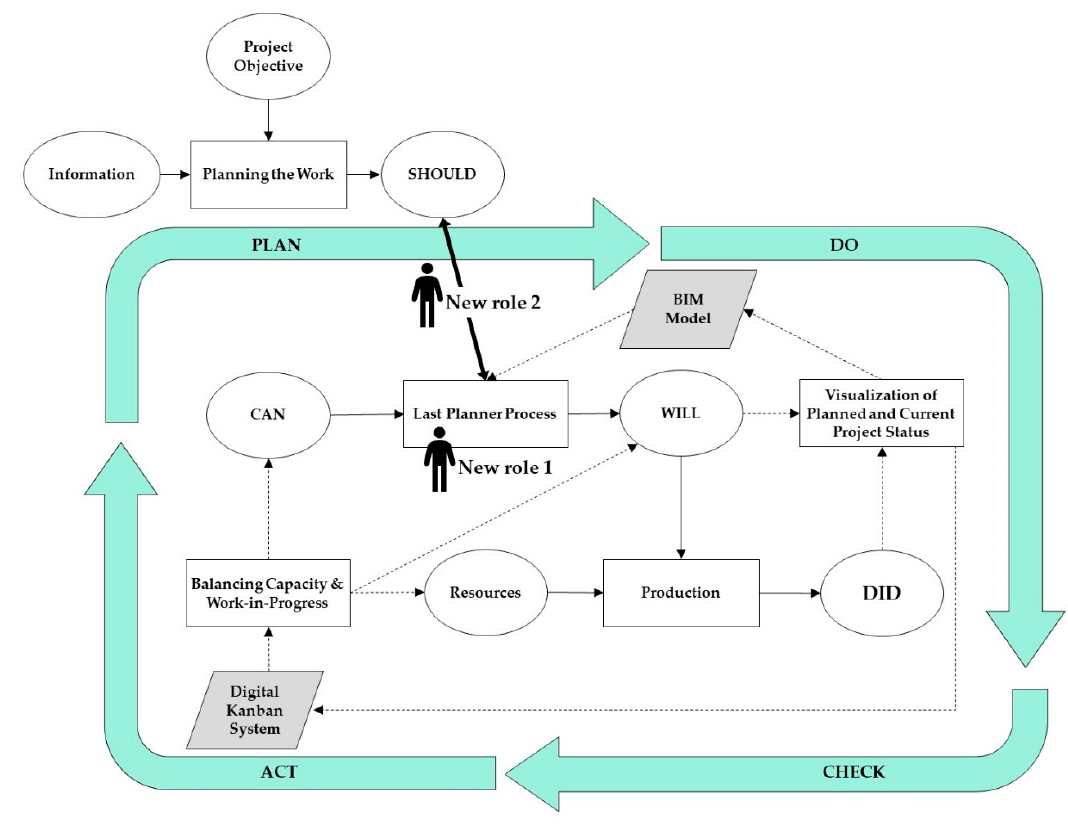
Figure 9. Conceptual model for BIM-LPS integration.